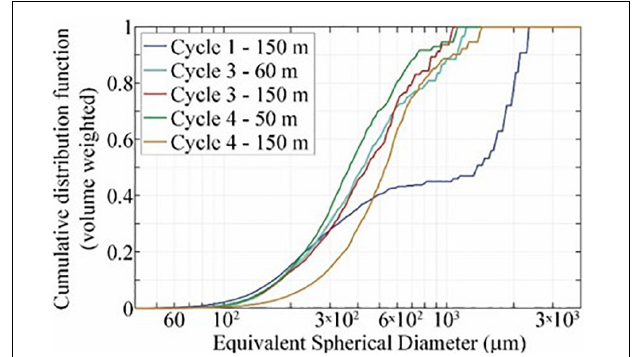
FIGURE 7 | Volume-weighted cumulative distribution function for particles that sank into acrylamide gel sediment traps on the P1706 cruise. Note that these do not include several large, porous marine snow aggregates that did not penetrate the